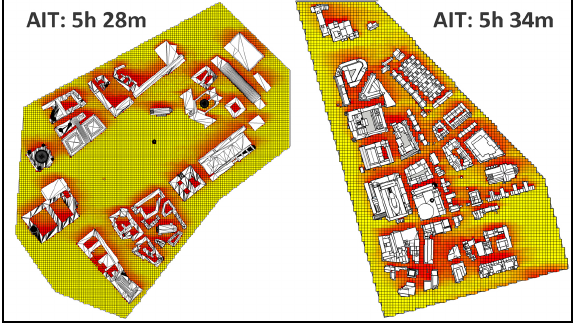
Figure 10.Comparison of different shadow patterns in public